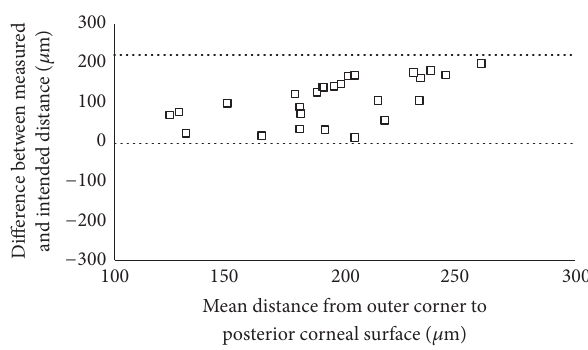
Figure 7: Scatterplot showing the differences between the measured and the intended distance from the Keraring outer corner to the posterior corneal surface. Individual differences between the measured and the intended distance are plotted against the mean value of the measured and the intended distance. The 95% LoA interval is represented with dotted